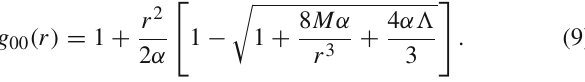
the mass range in which there are three horizons becomes more limited. Also, as regards each column, as α increases, the M cri 1 increases too, and